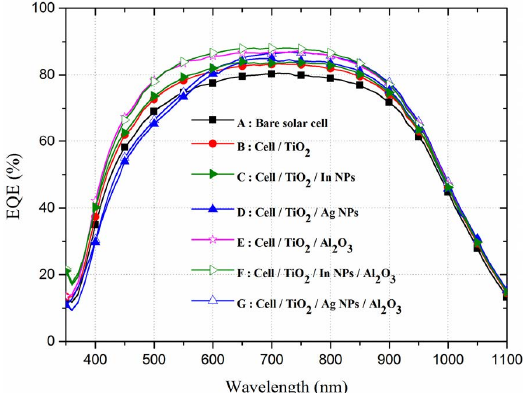
Figure 7. EQE response and optical reflectance of bare textured c-Si solar cell, cell with TiO 2 spacer layer, cell with Ag-NPs on TiO 2 spacer layer, and cell with Ag-NPs embedded in TiO 2 /Al 2 O 3 .